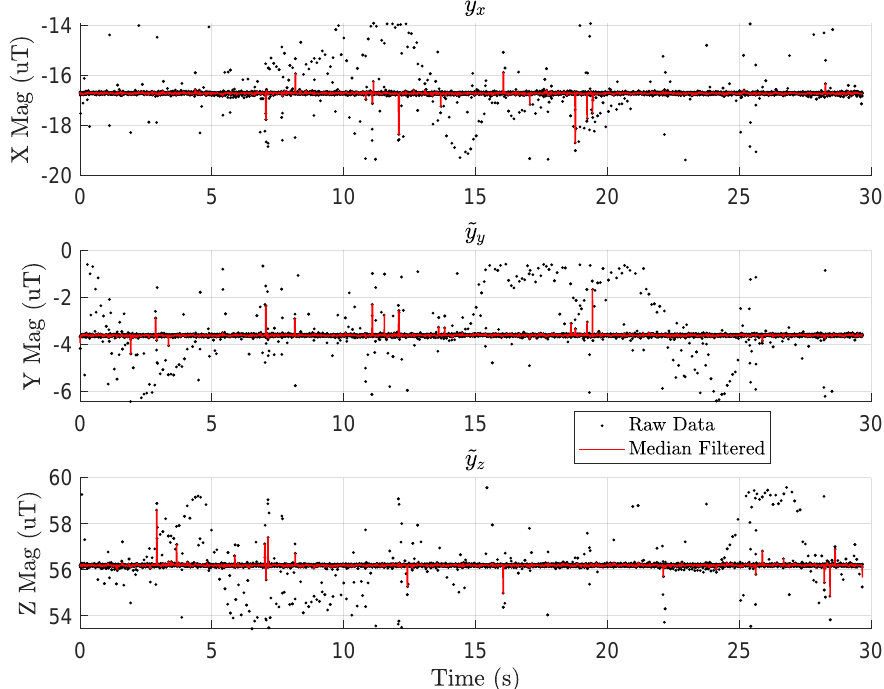
Figure 5. Data from a stationary RM3100 placed at the origin of the flight arena and sampled at 200 Hz. Spurious measurements are reduced with a moving median filter with a window size of